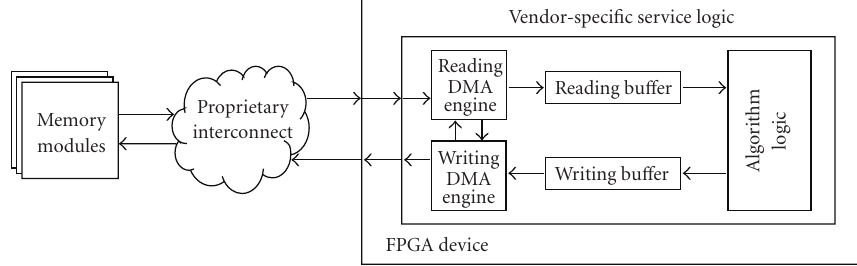
Figure 10: Streaming data transfer mode on reconfigurable